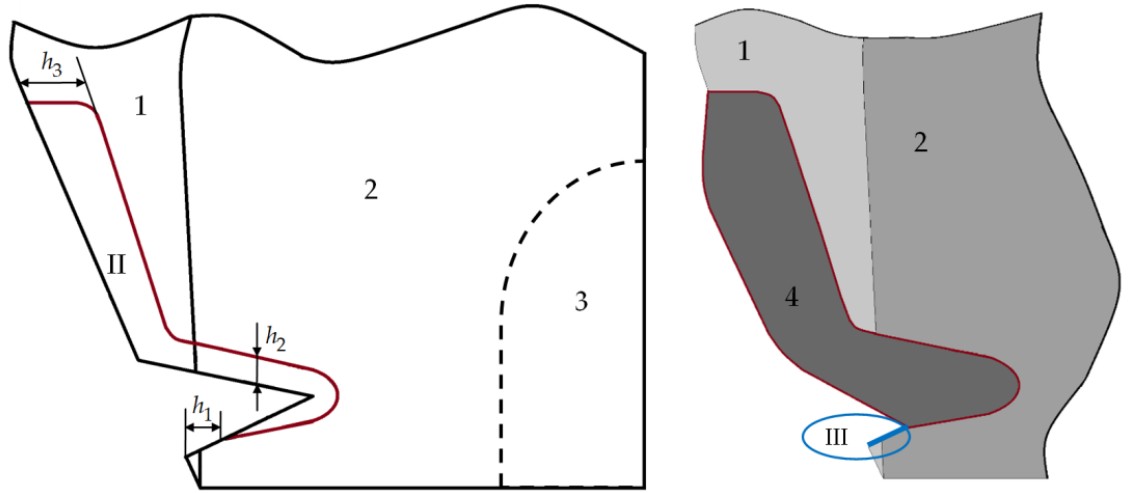
Figure 2. Modeling a cavity for a prosthetic inlay: 1 is enamel; 2 is dentine; 3 is pulp; 4 is inlay; II is cavity to fix the inlay; III is gingival fold.